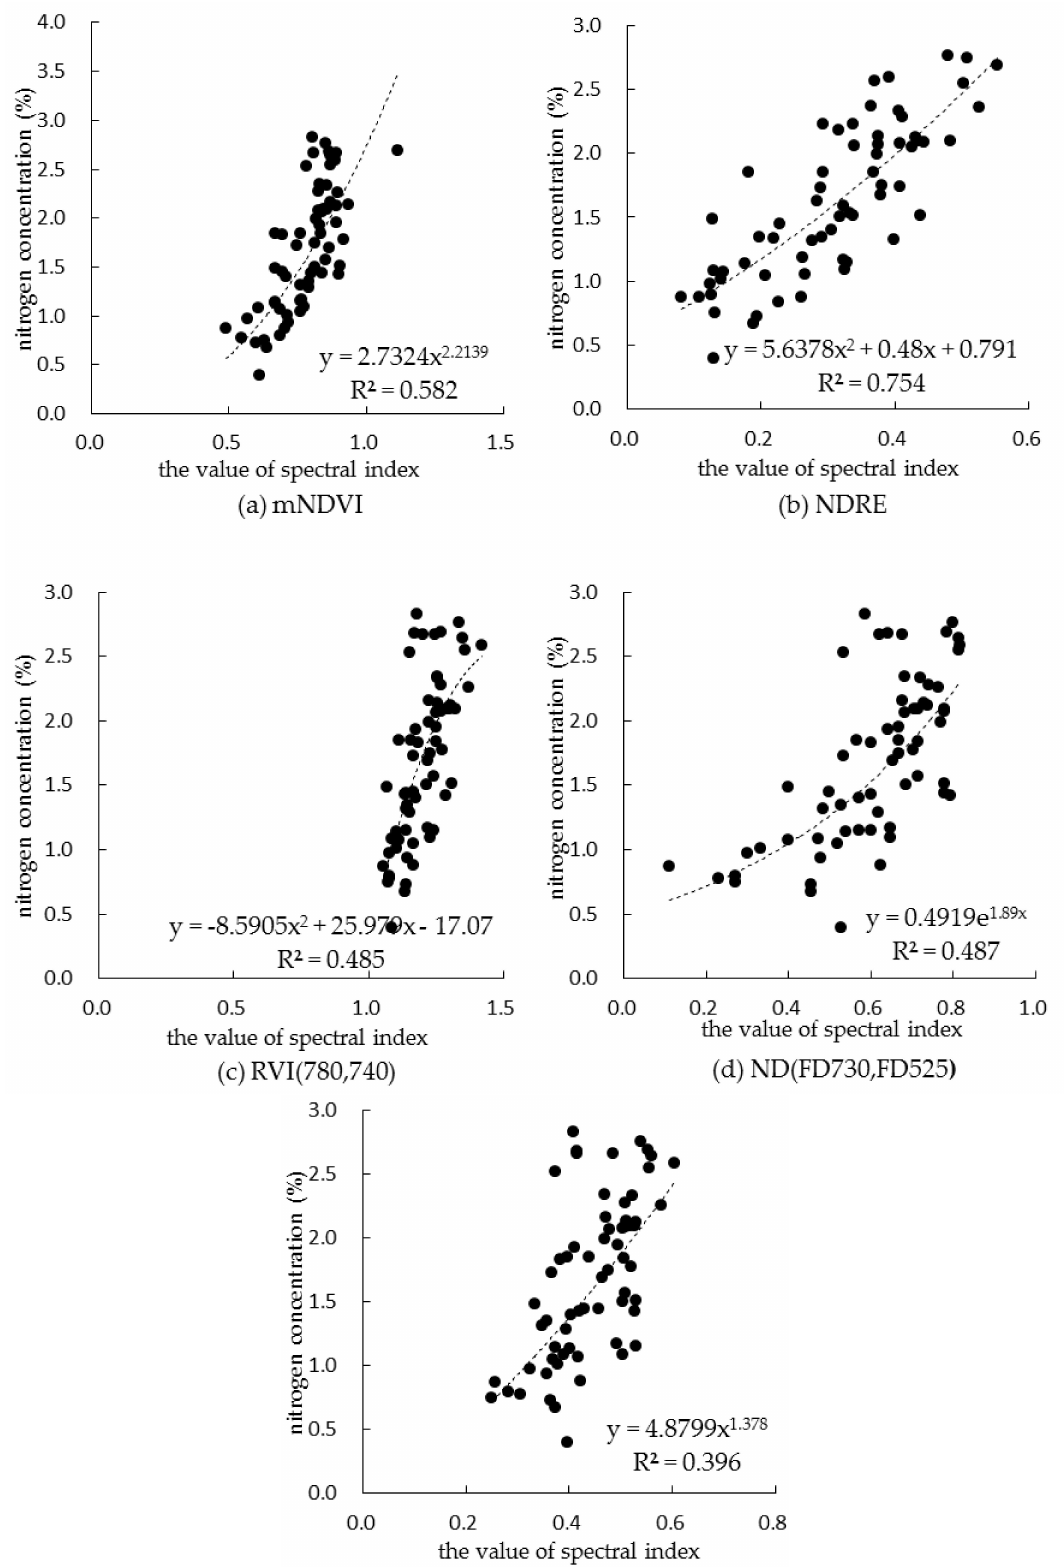
Figure 6. Fitting model of canopy nitrogen concentration based on top five spectral